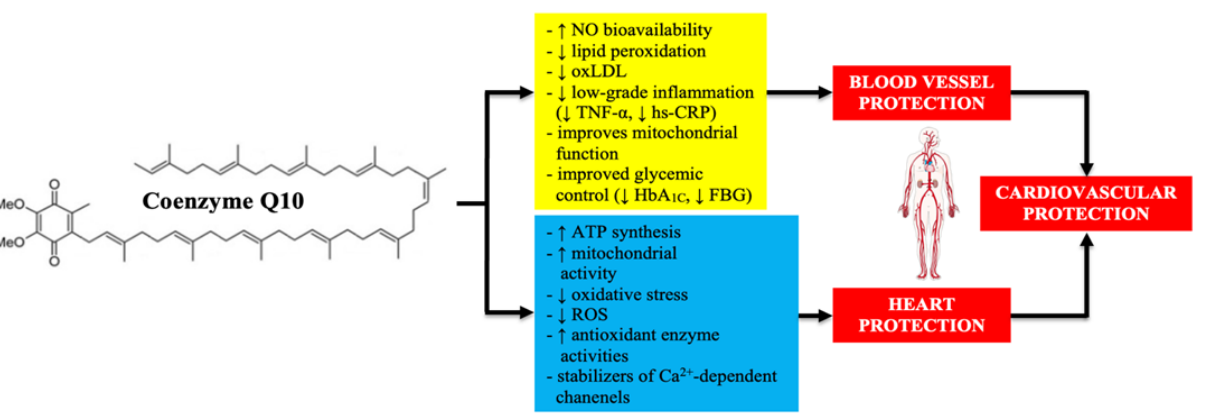
Figure 7. Cardioprotective properties of coenzyme Q10. Based on information from [10,15]. TNF- α — tumor necrosis factor α ; hs-CRP—high sensitivity C-reactive protein; HbA 1C —glycated hemoglobin; FBG — fasting blood glucose; ATP — adenosine triphosphate; ROS — reactive oxygen species . In a prospective randomized double-blind placebo-controlled trial (Ki-Sel-10) involv-